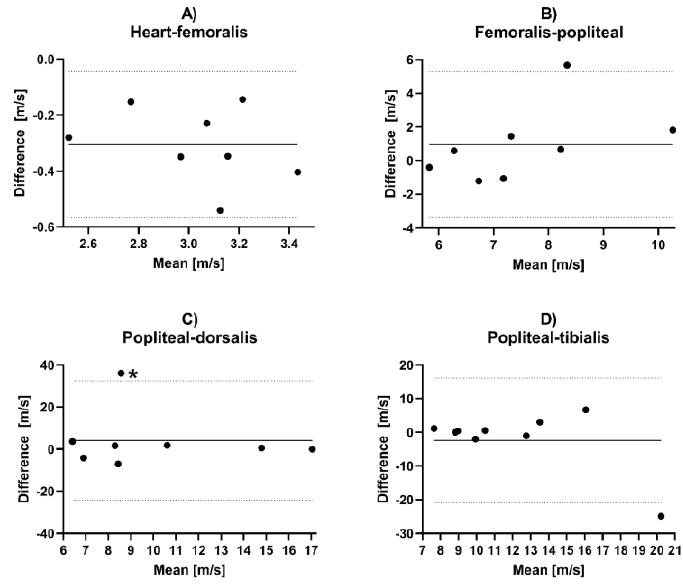
Figure 6: The distribution of the estimated pulse wave velocity (PWV) in meters per second (m/s) between the heart-a. femoralis; a. femoralis-a. popliteal; a. popliteal-a. tibialis posterior and a. popliteal-a. dorsalis from nine young healthy subjects by bioimpedance (Z) and tonometer (T) based on the mode of the pulse arrival time (PAT) in the arteries and distance between the measured sides.